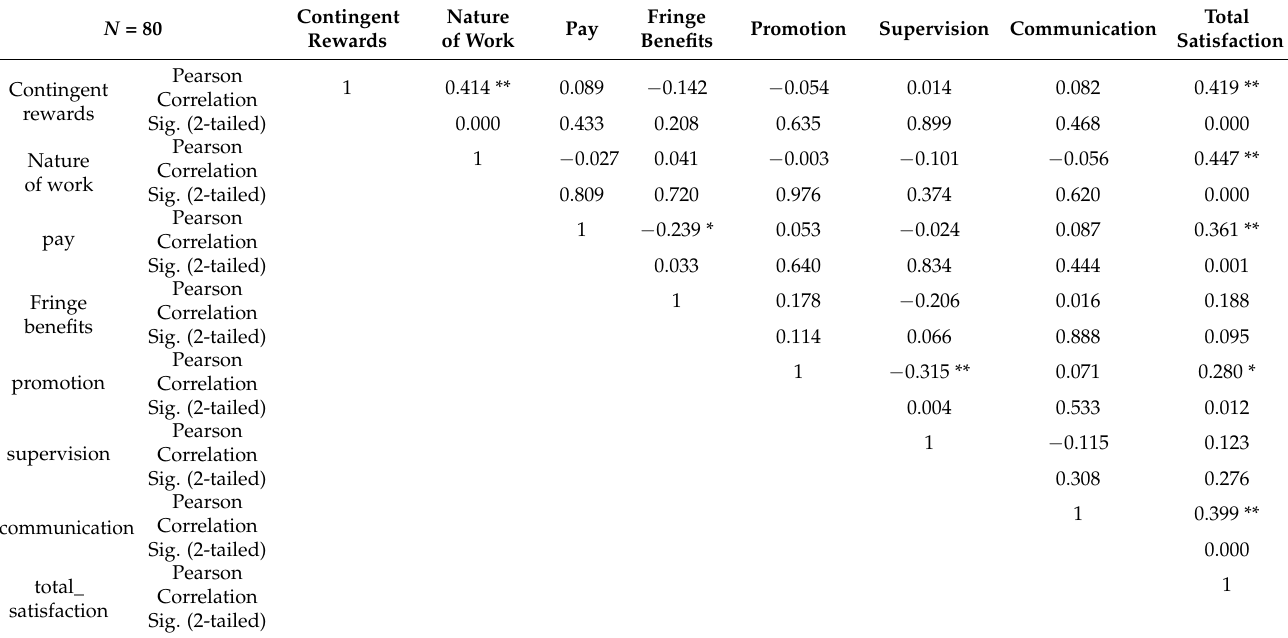
Table 7. Correlations between job satisfaction